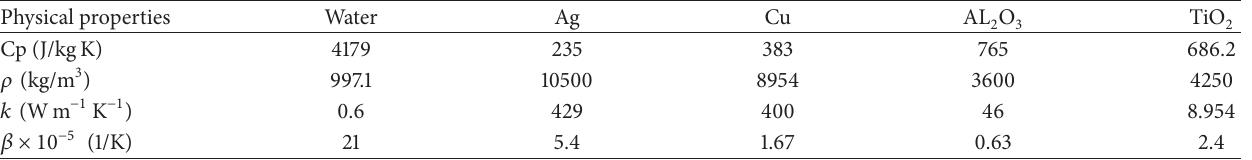
Table 1: Thermophysical properties of water with Cu [12], Al 2 O 3 [17], Ag, and TiO 2 [20].